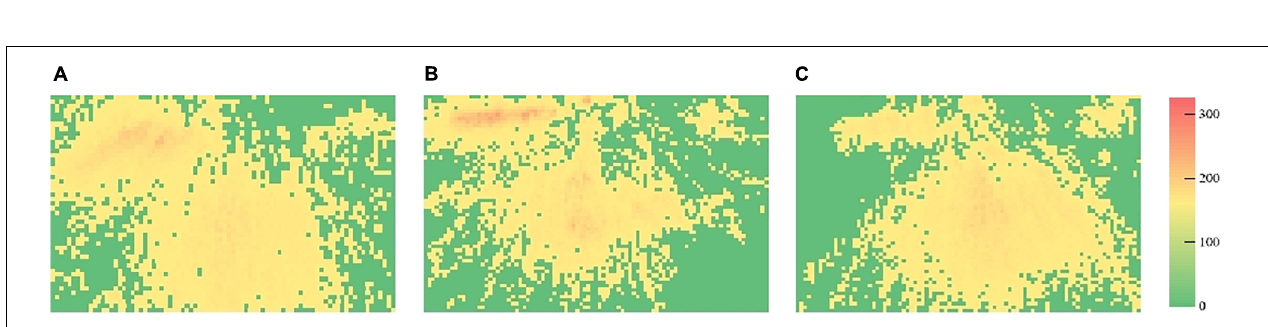
FIGURE 7 | Heat maps of course 2 ( A , heat map of subject 1; B , heat map of subject 2; and C , heat map of subject 3).